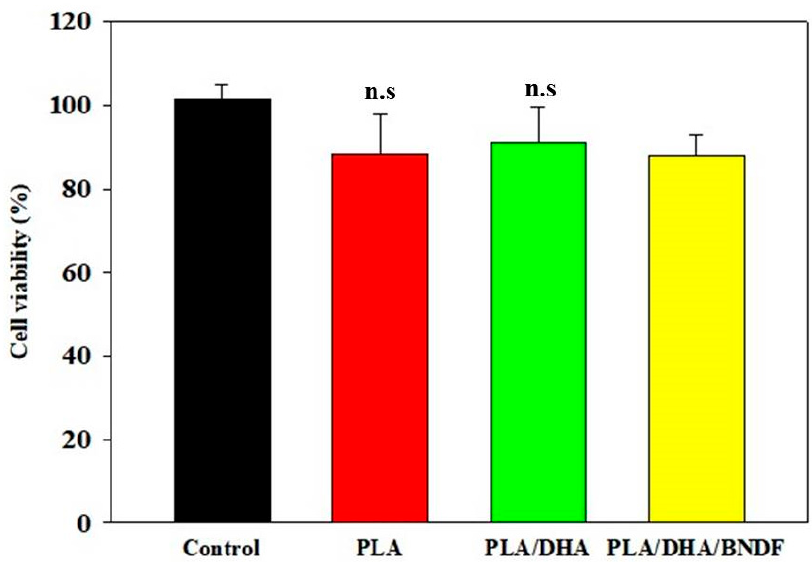
Figure 4. The cytotoxicity of PLA, PLA/DHA, and PLA/DHA/BDNF core–shell fibrous membranes (CSFMs). The fibroblasts were cultured with 24-h extract of a CSFM. The cell viability was compared with fibroblasts cultured with fresh cell culture medium (control), which was taken as 100%. The MTS assay was used to determinate the relative cell viability after cell culture for 24 h. n.s., not significant compared with control ( p > 0.05).